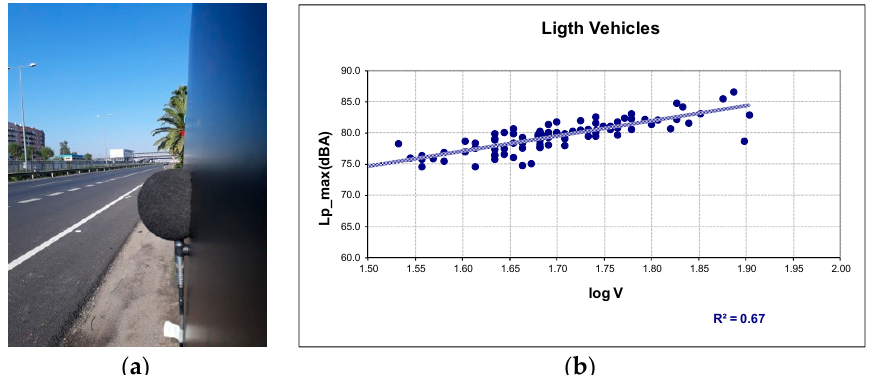
Figure 3. ( a ) Image of the statistical pass by noise test (SPB) test at A-376 site. ( b ) Results of Lp_max at A-8058 site for the regression analysis.